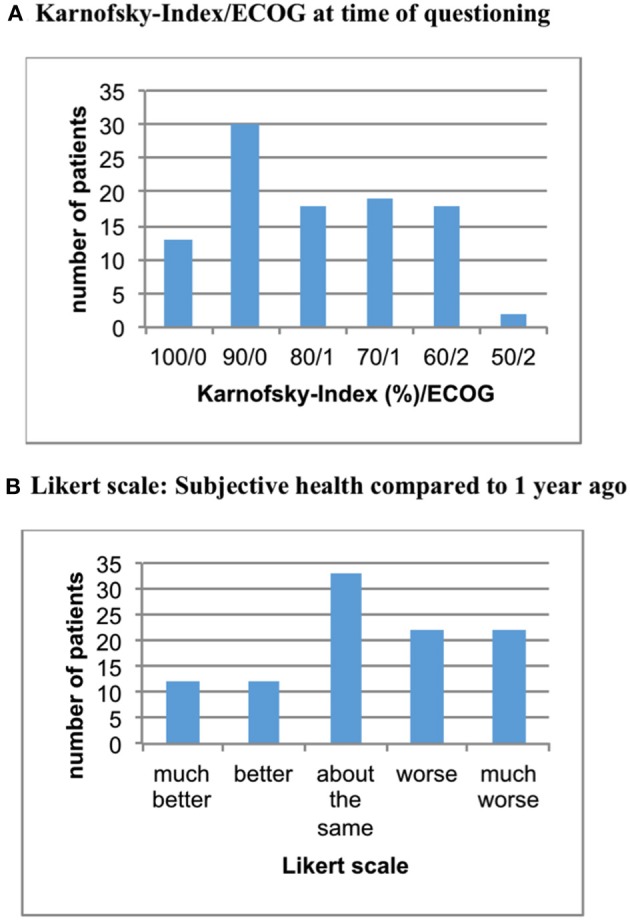
Functional status of patients at time of (A) and one year prior to (B) study conduction.